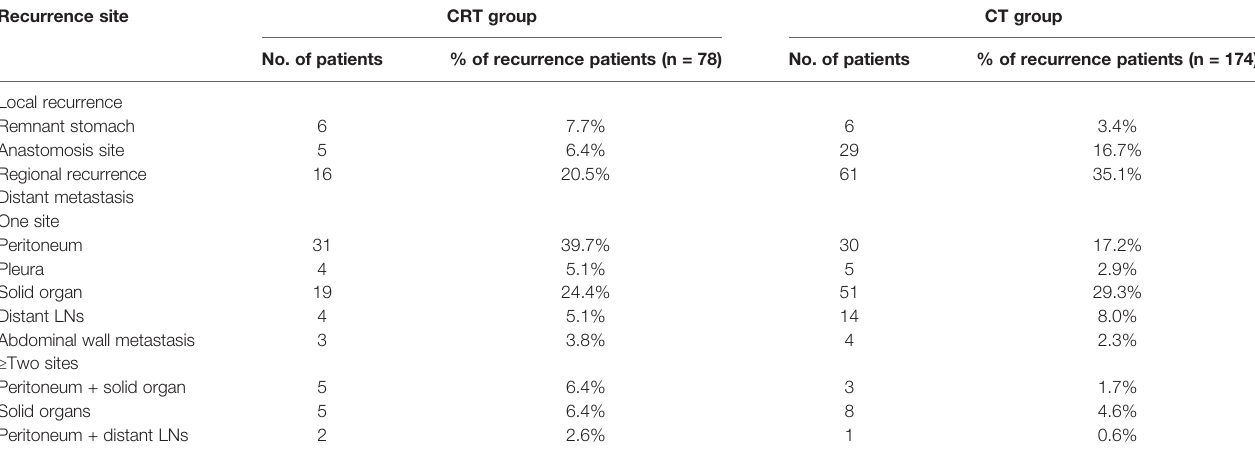
TABLE 2 | The distribution of recurrence in the CRT group and CT